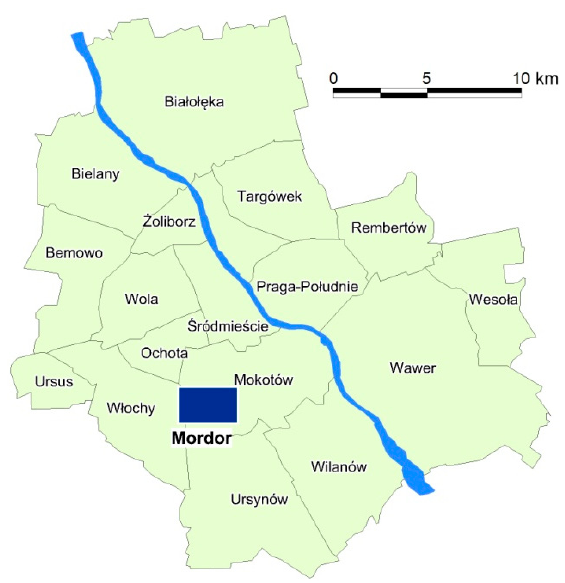
Figure 1. The location of the research area (the Varsovian “Mordor”) within the district division of Warsaw.